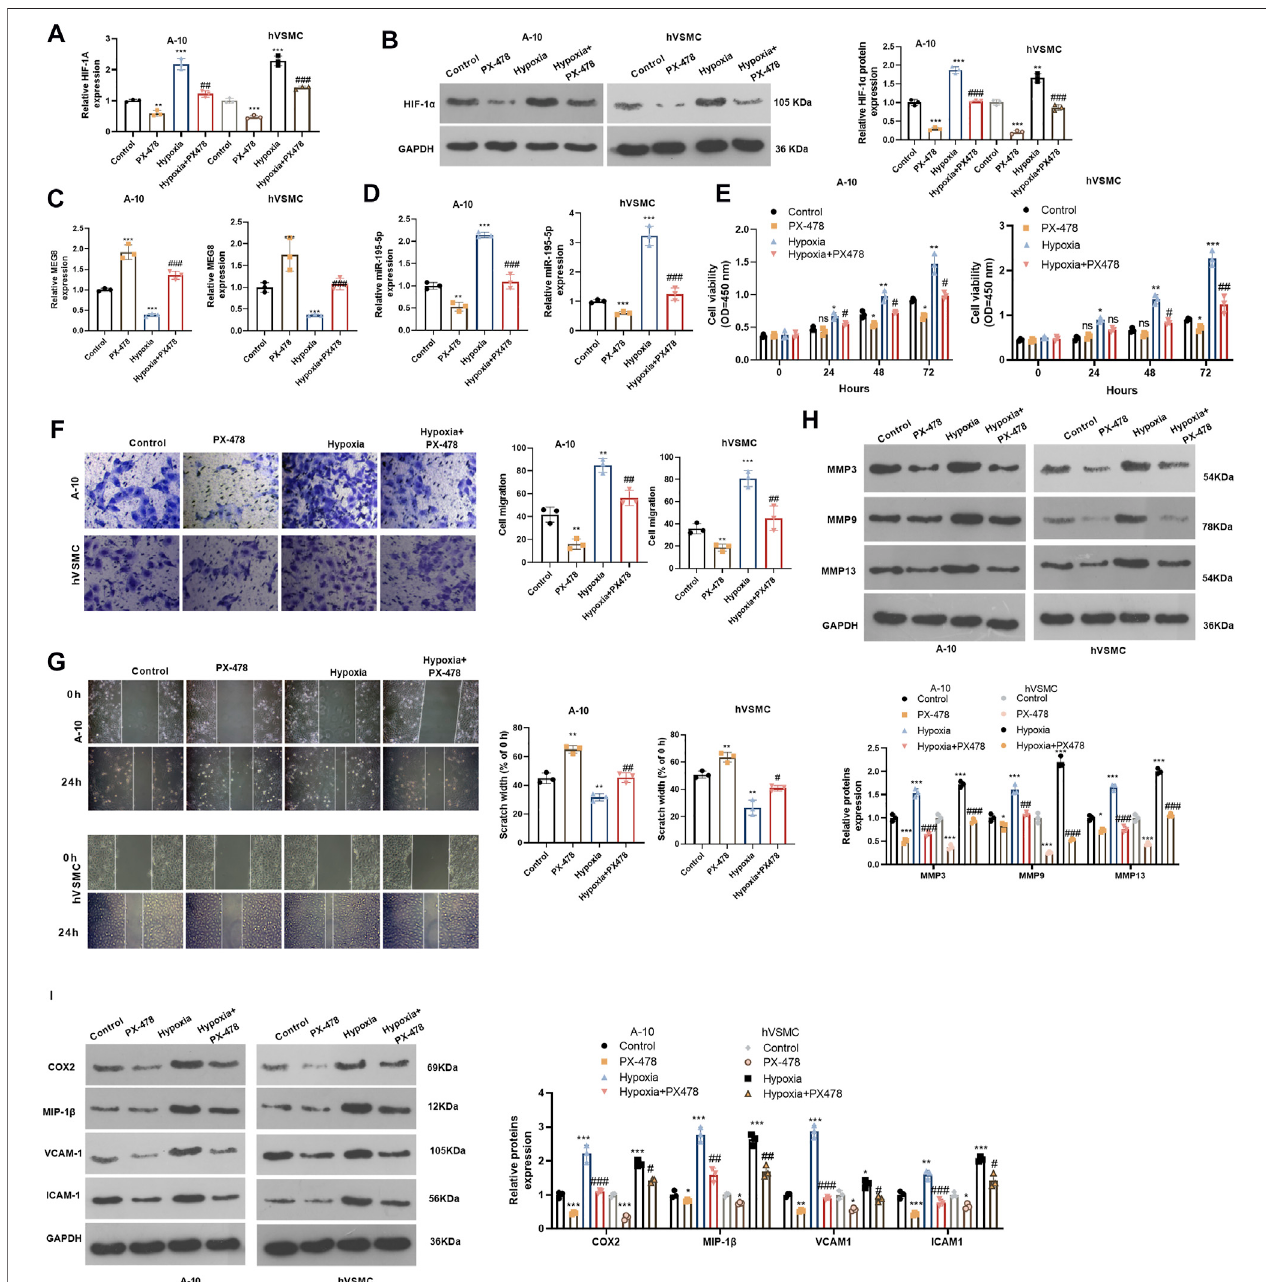
FIGURE7| Inhibiting HIF-1 α alleviatedhypoxia-induced abnormalproliferationandmigrationofVSMCs andenhanced MEG8expression. A-10cellsandhVSMCs were stimulated by hypoxia, and treated with, or without HIF-1 α inhibitor PX478 (25 μ M). (A,B) The mRNA and protein level of HIF-1 α were tested by qRT-PCR (A) and western blot (B) , respectively. (C,D) The expression of MEG8 and miR-195-5p was monitored by qRT-PCR. (E) Cell proliferation was measured by the CCK-8 assay. (F,G) Transwellandwoundhealingassayswereusedtodetectcellmigration. (H,I) TheexpressionofMMP3,MMP9,MMP13,COX2,MIP-1 β ,VCAM-1andICAM- 1 was analyzed by Western blot. NS p > 0.05, * p < 0.05, ** p < 0.01, *** p < 0.001 (vs. Control group); NS p > 0.05, # p < 0.05, ## p < 0.01, ### p < 0.001 (vs. Hypoxia group). All experiments were repeated three times, and each time was performed in